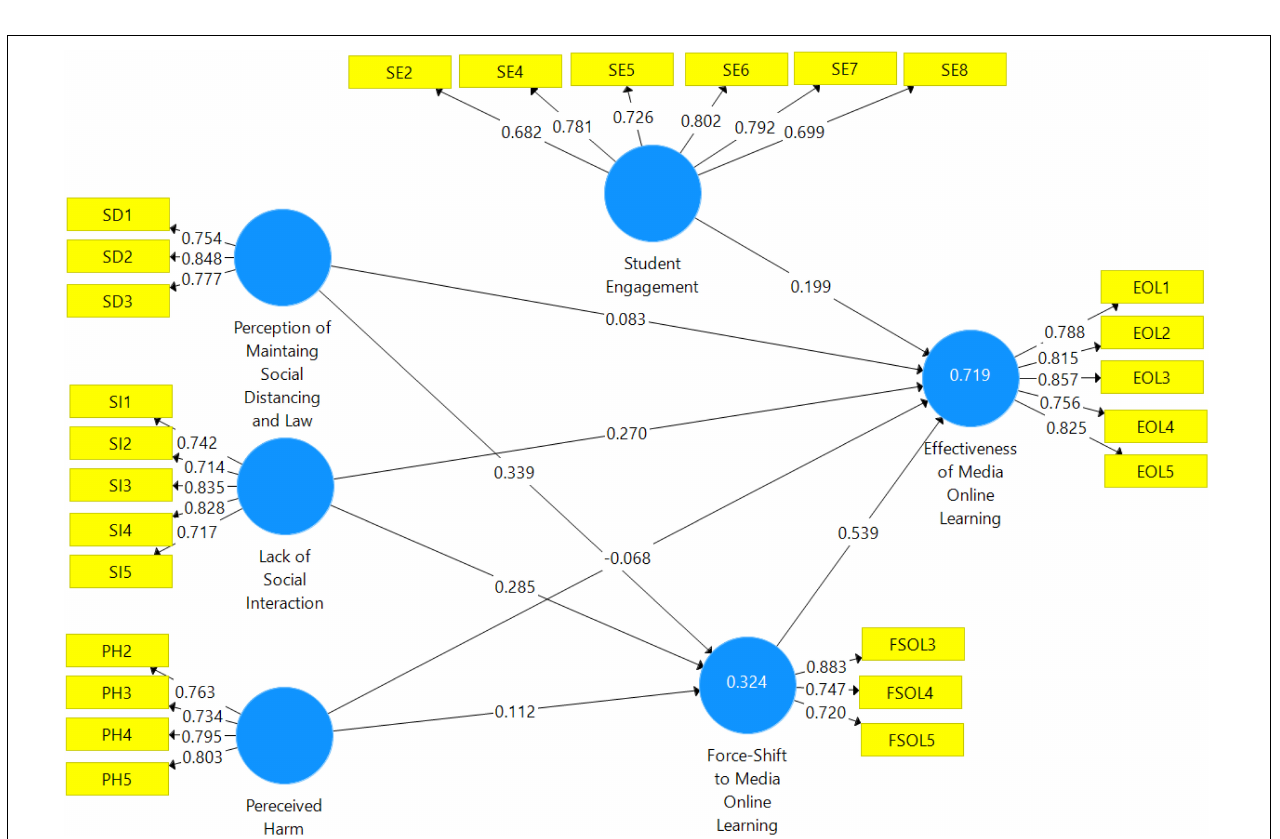
FIGURE 2 | Output of measurement model